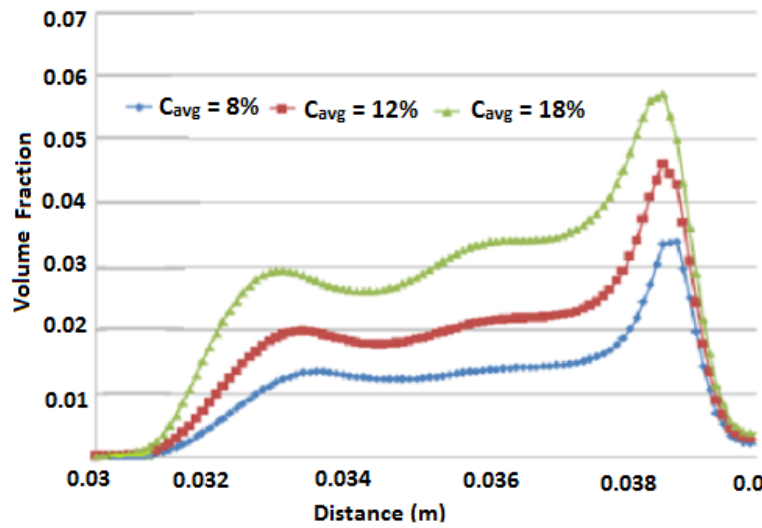
Figure 13. Comparison of solid phase volume fraction for different initial solid phase concentration in slurry sample W3 for R OH = 0.08 (132 RPM) and constant V = 7.78 m/s along Plane